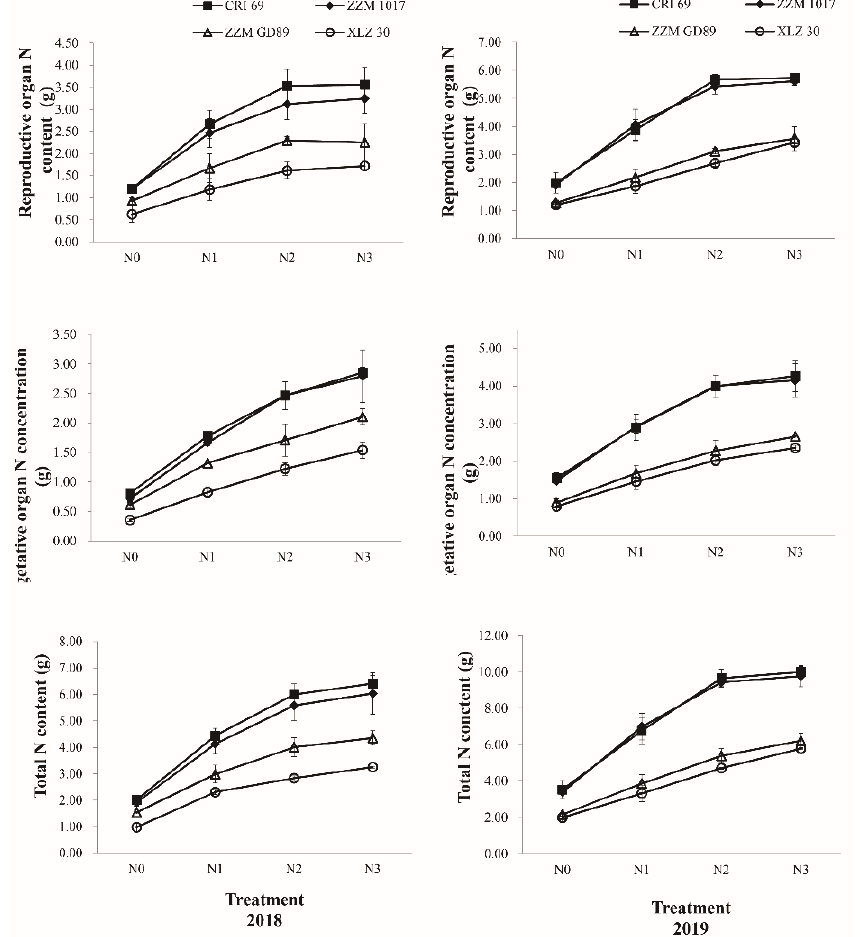
Figure 3. Differences in N absorbed of cultivars under different N-supply conditions in the 2018 and 2019. As shown in Table 4, NBE, NAR, NUpE, NUtE, as well as NUE varied significantly across years, cultivars and N fertilizers (except NHI). Additionally, the interaction effect of cultivar by N on N utilization were significant (except NBE, NUtE, and NHI). All of N utilization decreased as nitrogen increases, (except NHI). In comparison with N1 treatment, the NUE of N2 and N3 was reduced by 48% and 64% in 2018, and 46% and 63% in 2019, respectively. The mean NUE of CRI 69 and ZZM 1017 was higher 21%, 17%, and 14% in 2018 and 18%, 16%, and 11% in 2019 than that of ZZM GD89 and XLZ 30 at N rates (N1–N3), respectively (Figure 3), indicating that the NUE of CRI 69 and ZZM 1017 were significantly higher than that of ZZM GD89 and XLZ 30, and the difference between two different NUE cotton types can be reduced by applying more